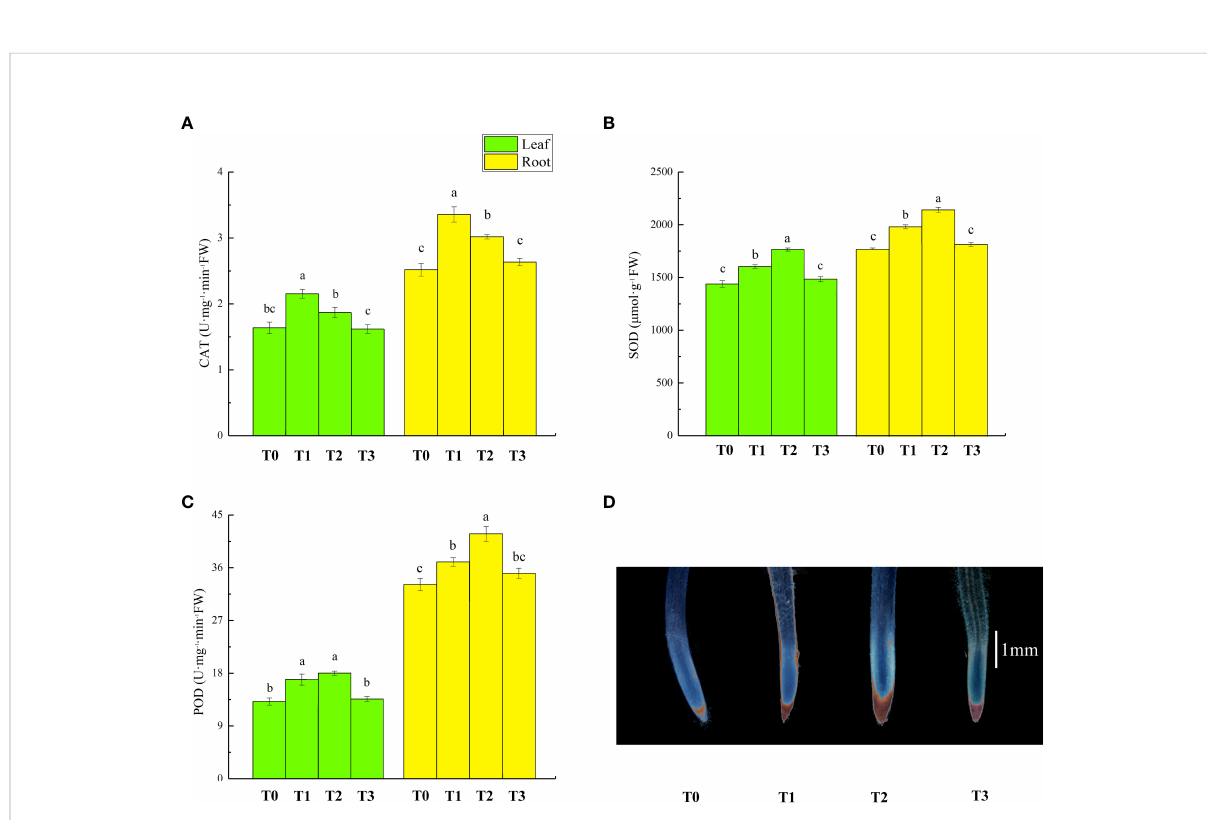
FIGURE 5 Effects of ZnONPs on the activities of catalase (CAT, A ), superoxide dismutase (SOD, B ), and peroxidase (POD, C ) in lettuce seedlings and pyrogallol staining of lettuce root tips (D) . T0, no treatment; T1, exposure to 1 mg/l Cd; T2, exposure to 1 mg/l Cd and 2.5 mg/l ZnONPs; T3, exposure to 2.5 mg/l ZnONPs. Brown color indicates the activity of cwPOD in lettuce roots and a large amount of brown color indicates higher cwPOD activity in roots, bar= 1 mm. Data are shown as means ± SE of three replicates. Bars marked by different letters indicate signi fi cant differences according to Duncan ’ s test ( p <0.05).